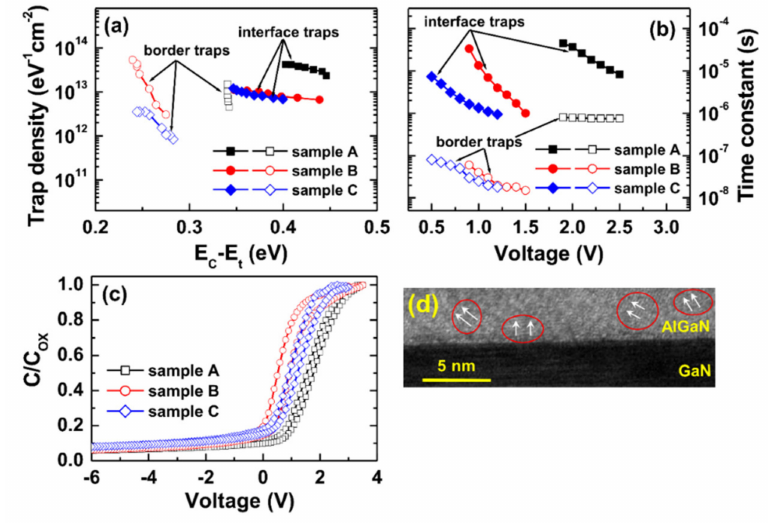
Figure 9. ( a ) Trap density vs. energy level, ( b ) time constant vs. voltage, ( c ) C – V hysteresis plots obtained at 100 kHz, and ( d ) cross-sectional scanning transmission electron microscopy (STEM) image for sample